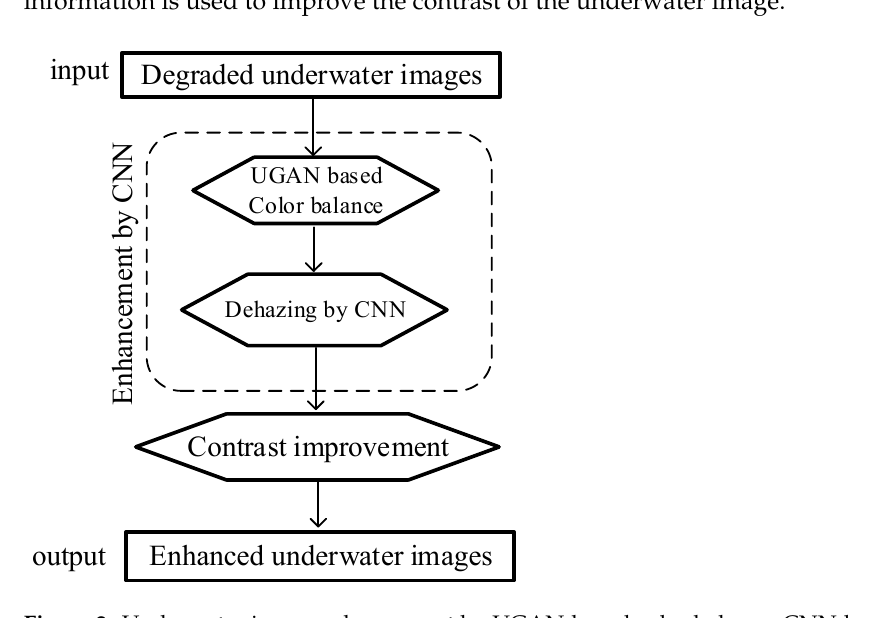
Figure 2. Underwater image enhancement by UGAN-based color balance, CNN-based dehazing, and contrast improvement.